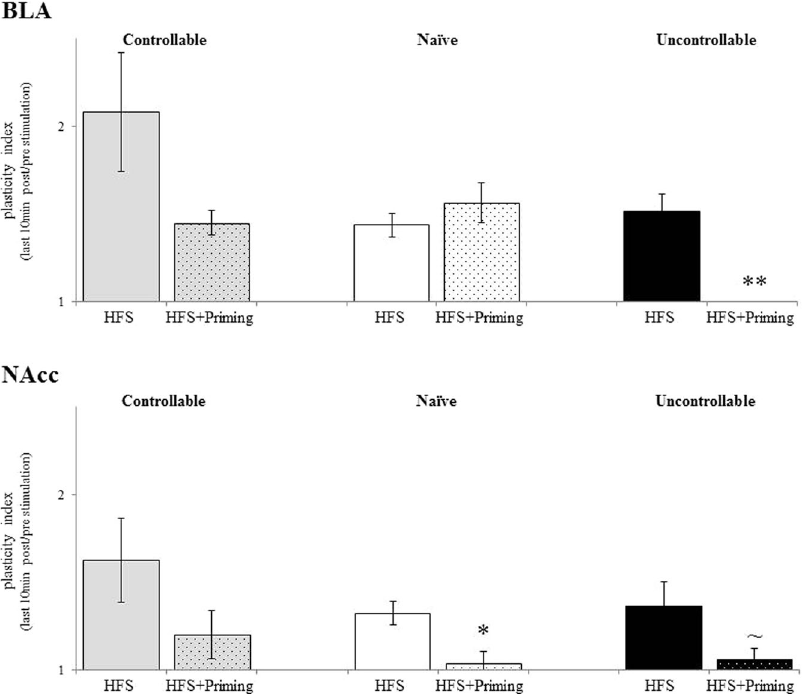
Figure 6. The interactive effects of group X stimulation protocols: within groups effects: a significant reduction in BLA plasticity index of uncontrollable rats following priming + HFS stimulation, compared to HFS stimulation was found ( ** p < 0.001). A trend was found for the NAcc plasticity index in this group [p = 0.07]. A significant reduction in NAcc plasticity index following priming + HFS stimulation, compared to HFS stimulation was found also in naïve animals [p < 0.05]. No changes in plasticity indices were observed in the controllable group, neither under HFS stimulation nor under priming + HFS